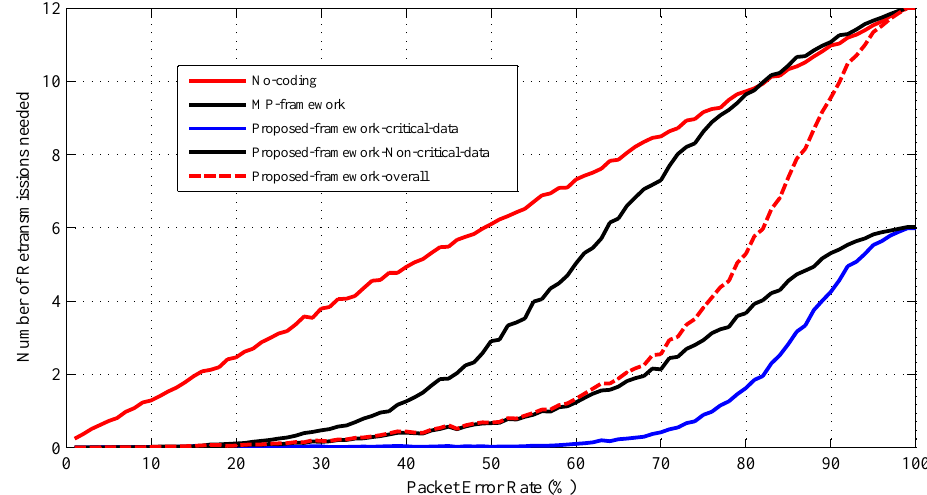
Figure 11. Performance comparison in terms of the number of retransmissions needed.